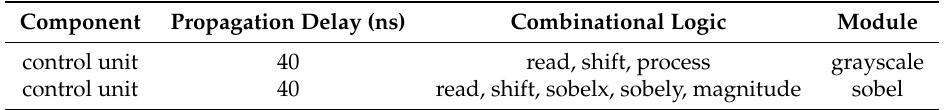
Table 1. Design Timing Analysis 1.